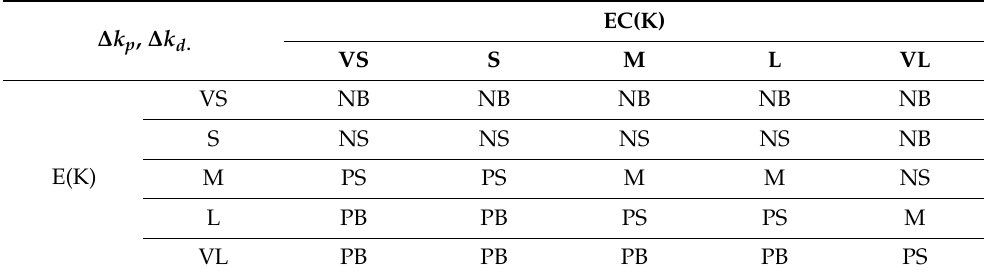
Table 1. Fuzzy rule base design for E(K) and EC(K).